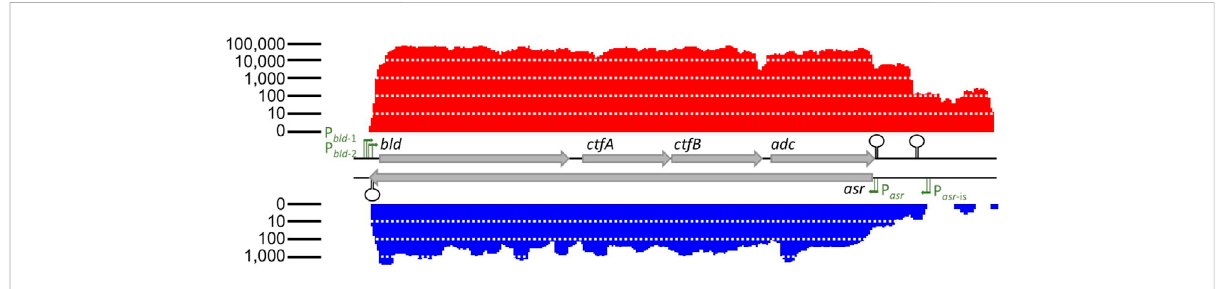
FIGURE 1 Expression levels of sol mRNA and Assolrna. Red, transcriptional activity of sol mRNA; blue, transcriptional activity of Assolrna; grey arrows, genes encoding butyraldehyde dehydrogenase ( bld ), CoA-transferase subunits α ( ctfA ) and β ( ctfB ), acetoacetate decarboxylase ( adc ) (Cspa_c56880toCspa_c56910),andAssolrna( asr ).Transcriptionalactivityisthecalculatedbasecoveragefrommappedreads(Dietrichetal.,2014). Green arrows with lines, promoters of respective genes depicting the − 10 and − 35 regions; stem-loop structures, terminators. There is a sharp decrease in transcriptional activity at the end of the displayed transcript, but no terminator was identi fi ed. Transcriptional activity at both ends of the fi gure were not cut off intentionally, they indeed ended there.